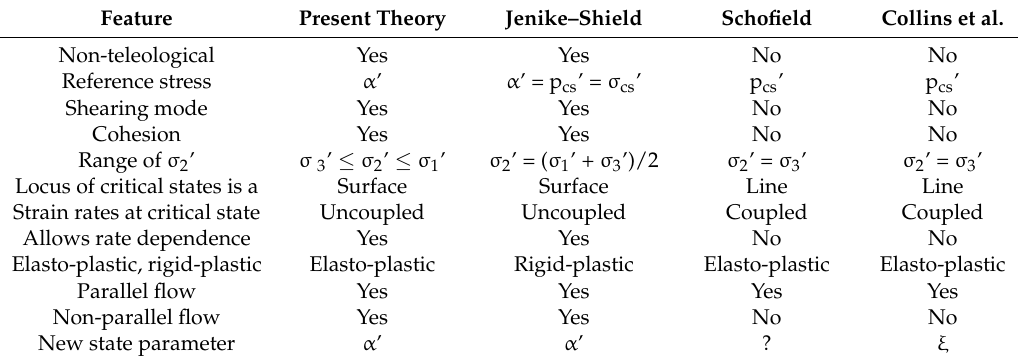
Table 1. Comparison of theories of rupture strength for a granular